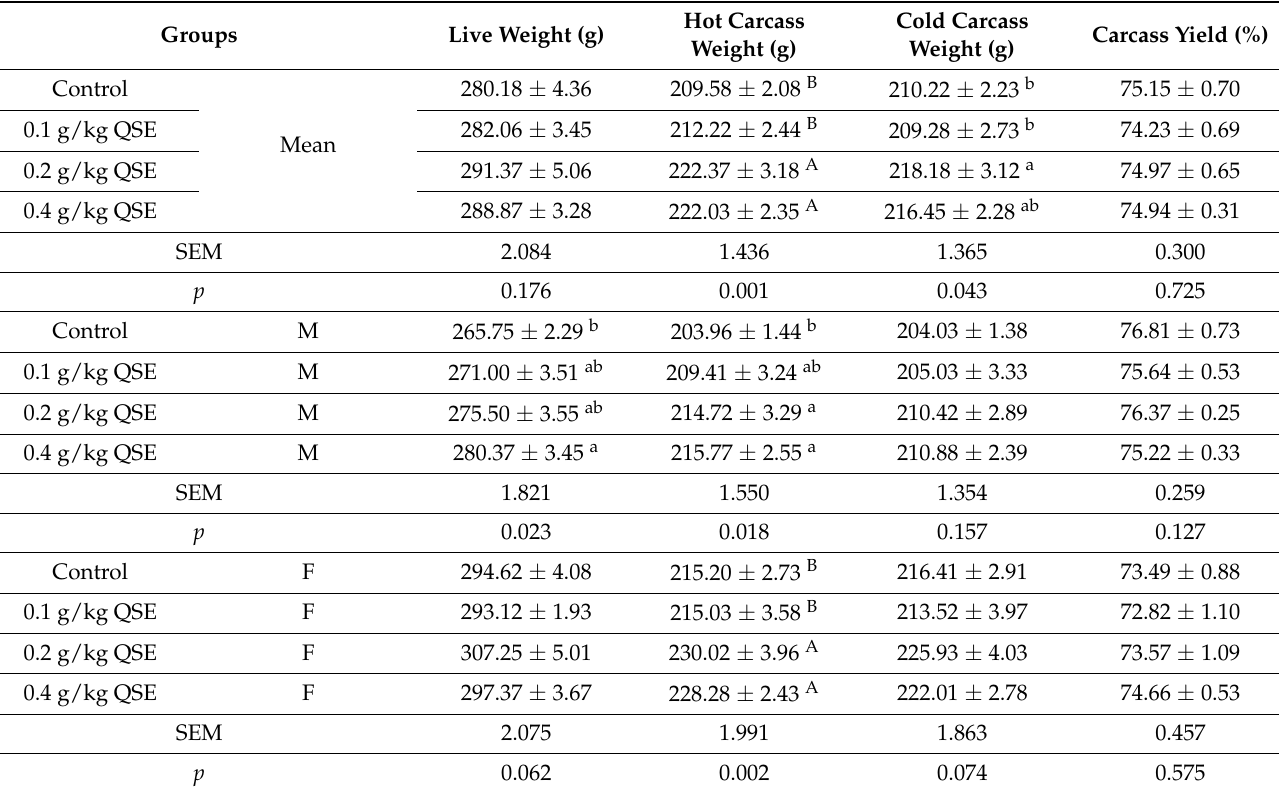
Table 6. Carcass values of experimental groups